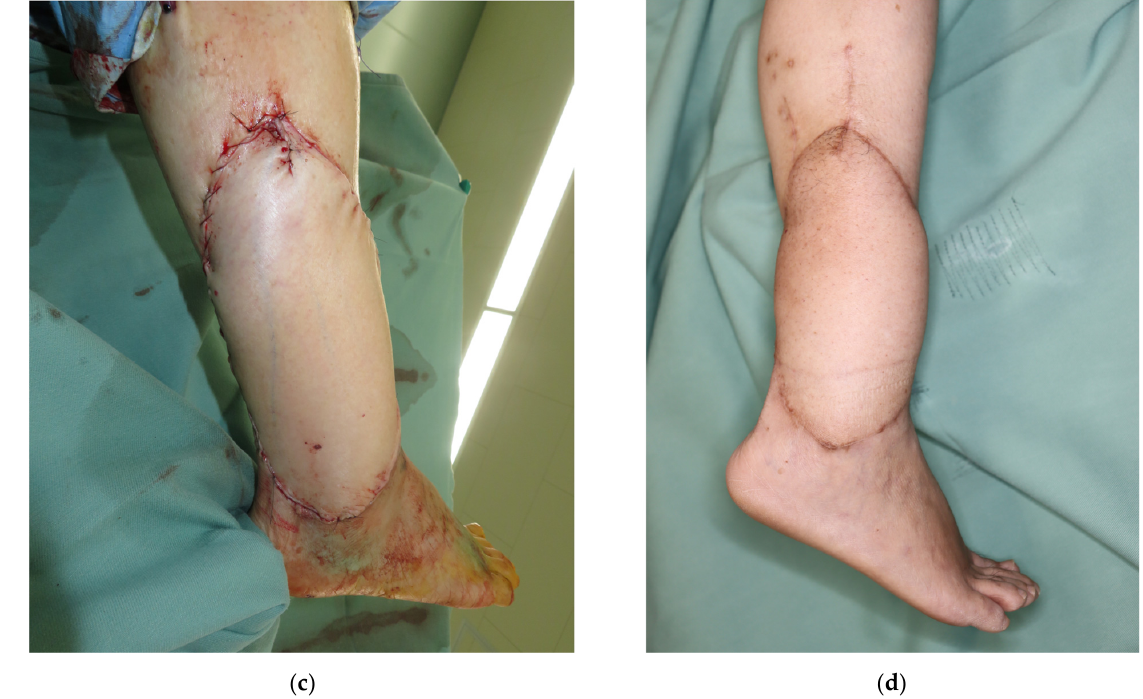
Figure 6. ( a ) Flap design. The flap was elevated based on the SCIA superficial branch. ( b ) The flap was elevated using the DFS technique. ( c ) Immediate postoperative photo. ( d ) Postoperative photo at one year.